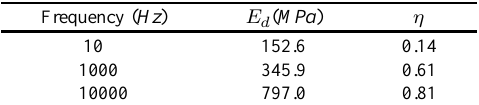
Fig. 4. The effect of cavity resonances on noise reduction for a hollow aluminum cylinder with a/b = 0.994, (a) The noise reduction for three values of circumferential wave number (b) The amplitude of the F (cid:2) n vs non-dimensional frequency. Table 2 Mechanical properties of the rubber in three